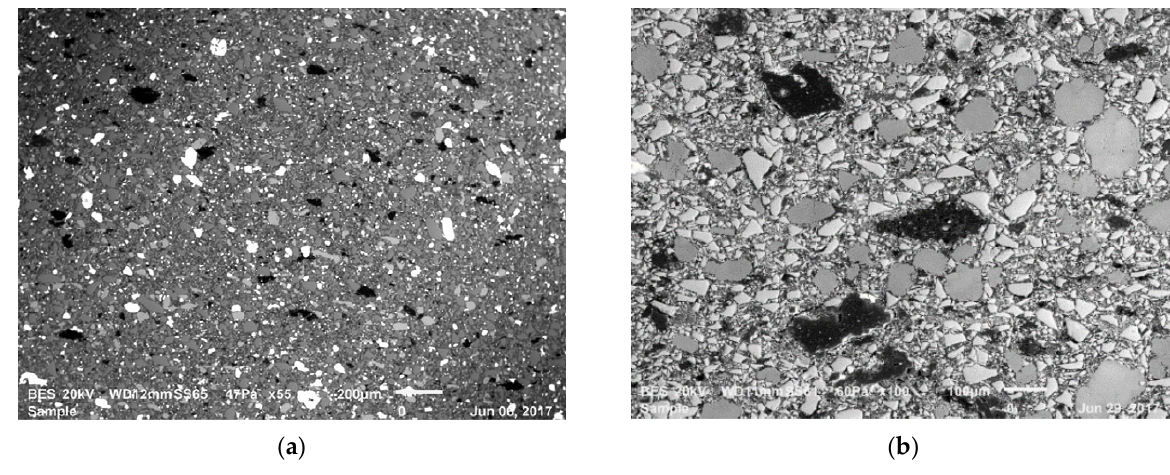
Figure 7. General microstructure of the composite. ( a ) ENRF [35]; ( b ) EBAL [34].